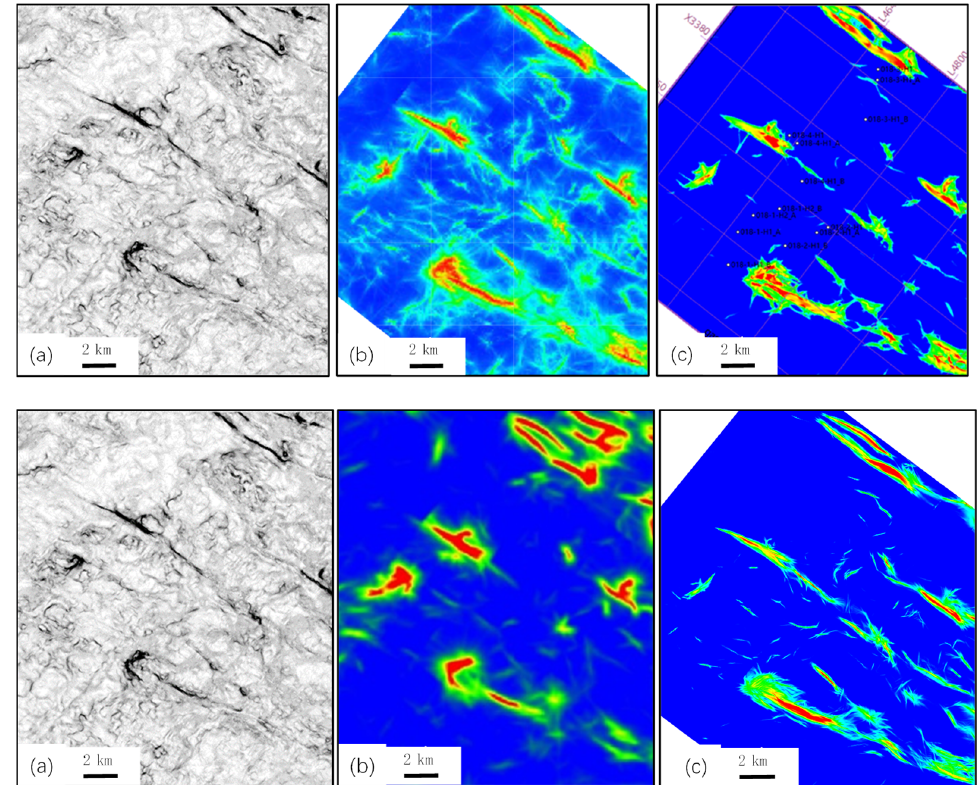
Figure 7. ( a ) Coherence, ( b ) seismic illumination and ( c ) fusion attribute of seismic illumination and structural tensor showing the NE ‐ trending strike ‐ slip fault damage zones in the Anyue Gasfield (the green envelope suggests the fault damage zone, and the orange ‐ red blocks suggest the strong fractured zones).